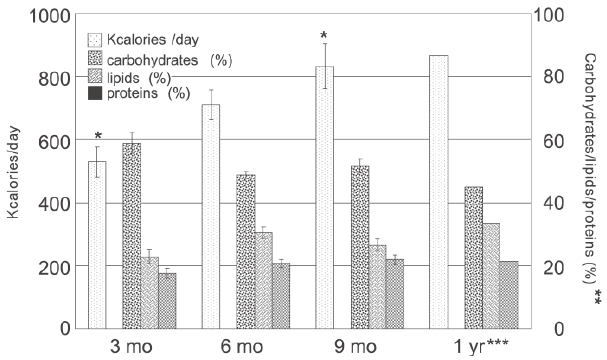
Figure 3 - Macronutrient ingestion (mean ± SEM). (*) Calorie intake at 9 months > 3 months ( P <0.05); (**) Differences for percentages not statistically significant: (***)Values for 1 year were insufficient for